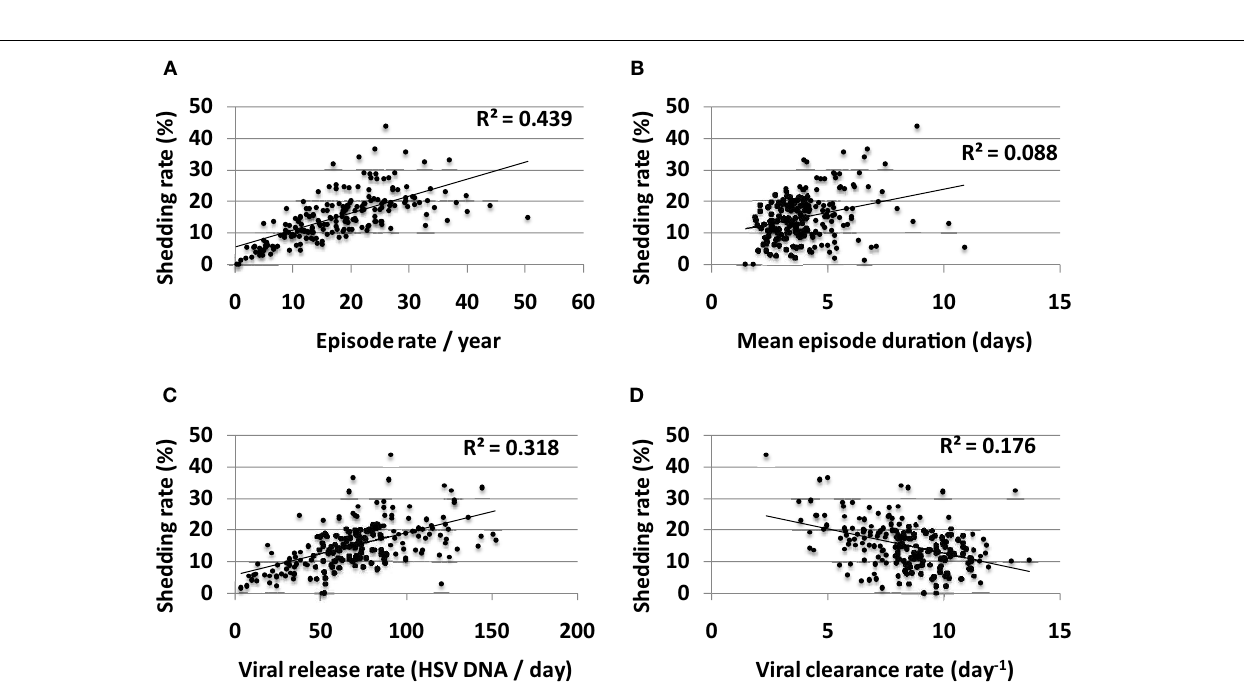
FIGURE 8 | CD8 + T-cell influenced parameters that are important mediators of short-term viral control have only a limited impact on long-term shedding rates . (A) CD8 + T-cell expansion rate expansion rate predicts slightly lower shedding rate. (B) HSV DNA replication rate has no